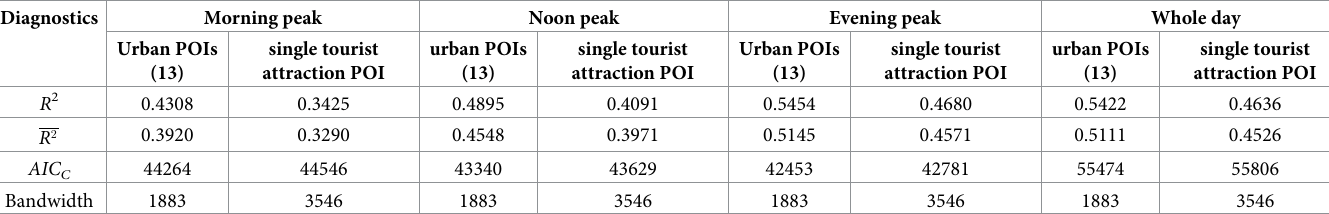
Table 6. Comparison results of the GWR model between urban POIs (13) and single tourist attraction POI on weekdays. Diagnostics Morning peak